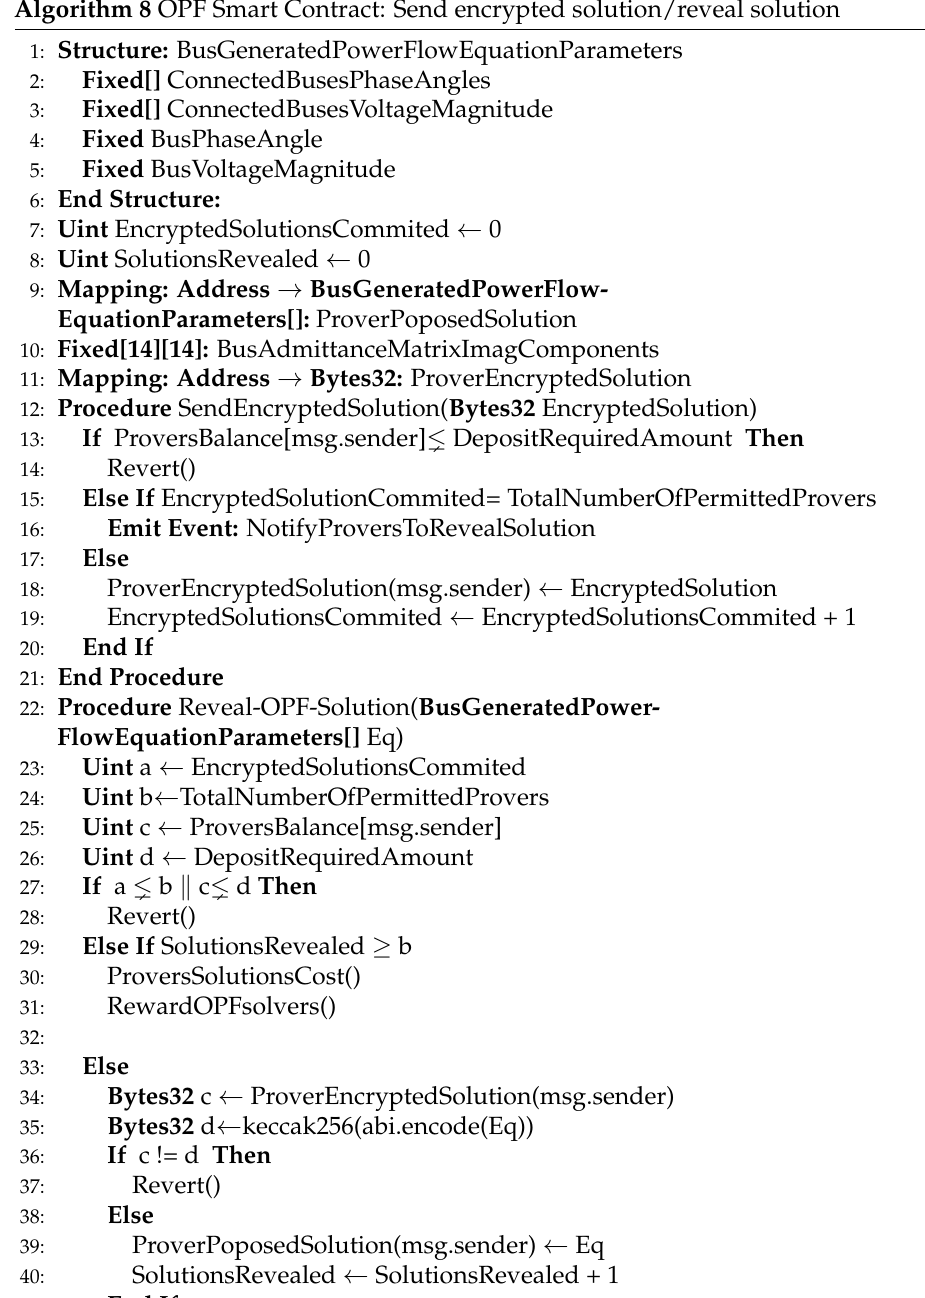
Algorithm 8 OPF Smart Contract: Send encrypted solution/reveal